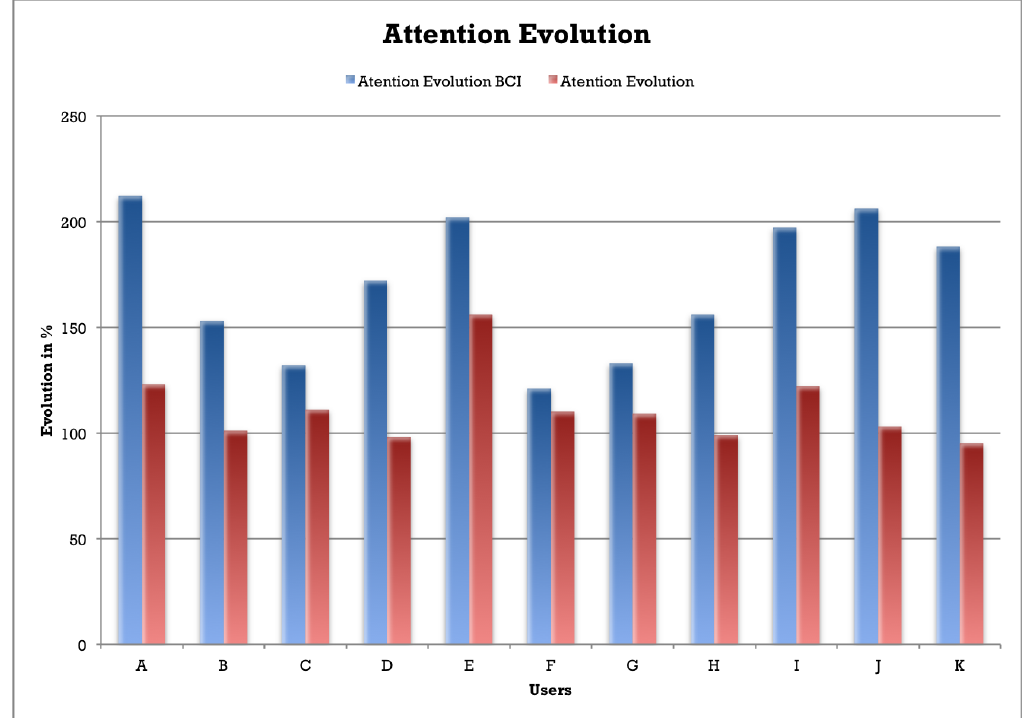
Figure 6: Evolution of Attention level of User Group comparing the first and last